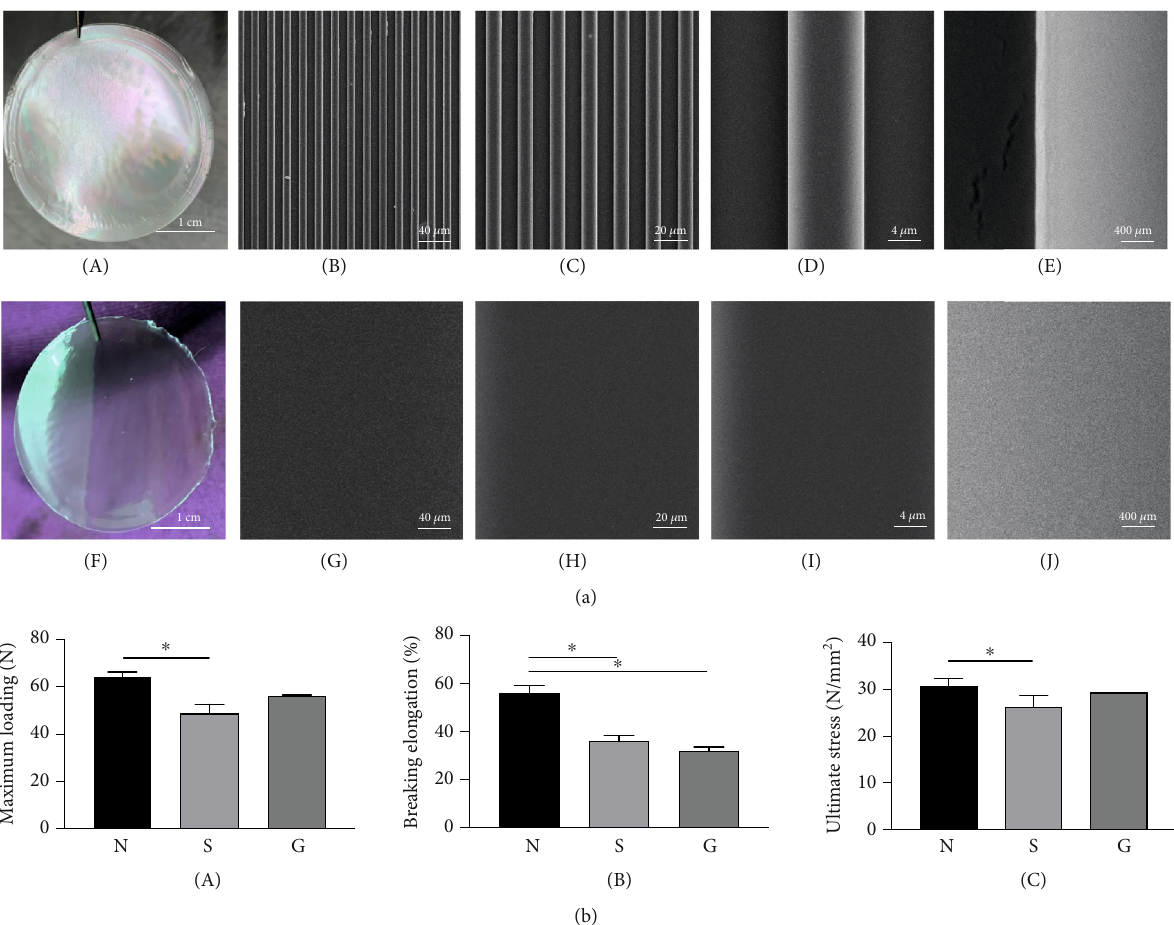
Figure 2: SEM and mechanical test. (a) Characterization of SF fi lms: (A) the photograph of the SF fi lm with a microstructure; (B – E) the SEM images of the SF fi lm with a microstructure; (F) the photograph of the smooth SF fi lm; (G – J) the SEM images of the smooth SF fi lm; magni fi cations: 2,000x (B, G), 10,000x (C, H), 20,000x (D, I), and 100,000x (E, J). (b) Mechanical properties of the native tendon (group N), smooth SF fi lm (group S), and SF fi lm with a microstructure (group G): (A) maximum loading, (B) breaking elongation, (C) ultimate stress; ∗ P < 0 : 05 angle (Figure 3(b), E – H, P = 0 : 0031 ), and a reduced cell area (Figure 3(b), I – L, P = 0 : 0039 ), suggesting that the seeded cells on SF fi lms with a bionic microstructure had di ff erent oriented arrangements with a slender cell morphology.